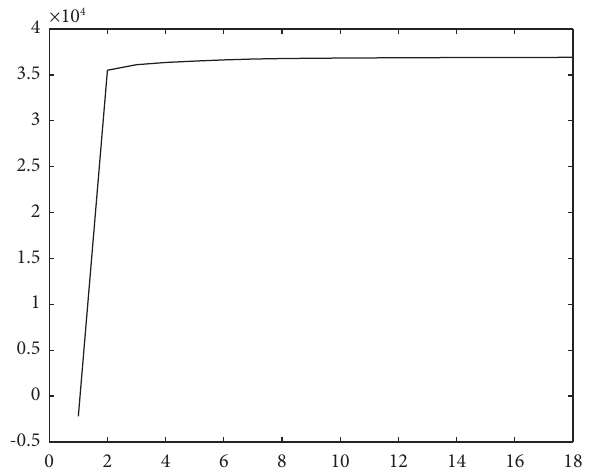
Figure 13: HMM training curve of CSTR process.